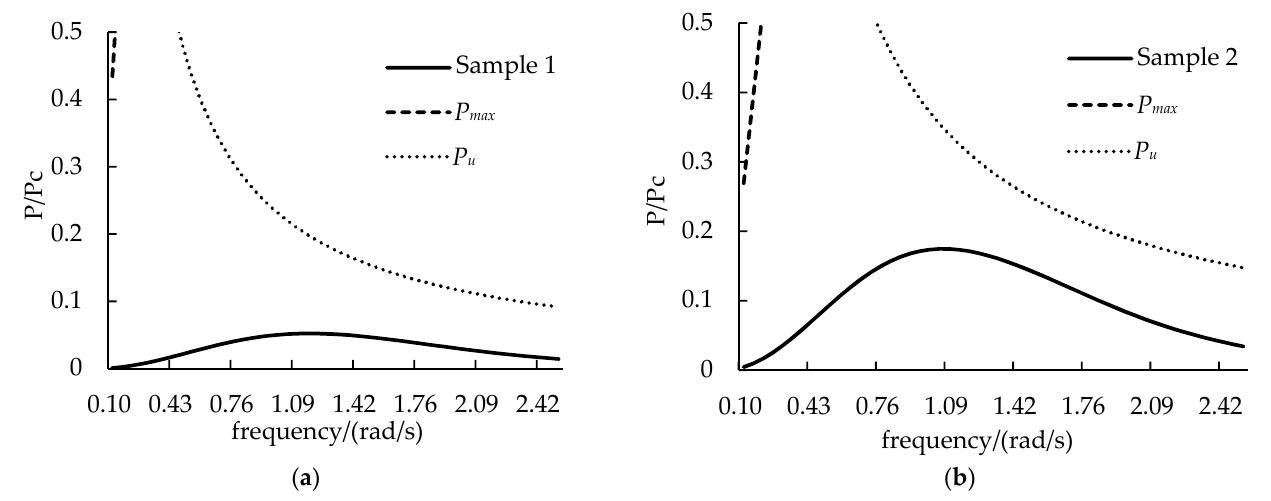
Figure 6. Power curves from simulations and theories. ( a ) results of sample 1; ( b ) results of sample 2.